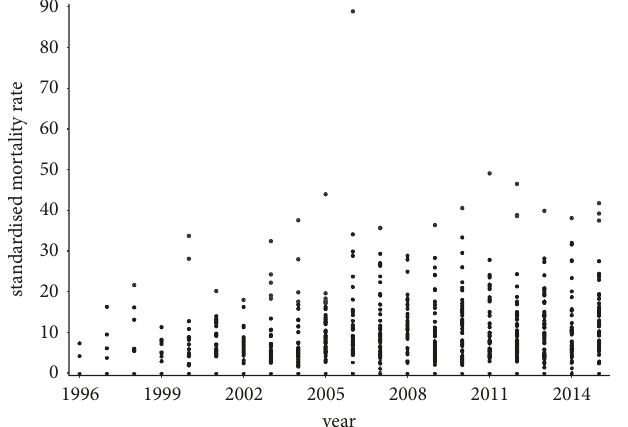
Figure 8: The standardised mortality rate of the individual districts of the Slovak Republic for the male sex throughout the whole period.